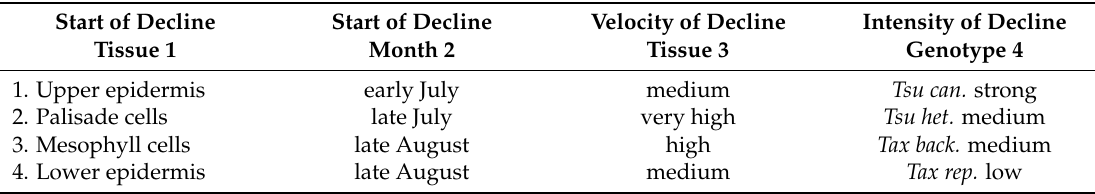
Table 2. Start and monthly sequence of the decline of the 4 needle tissues (Columns 1 and 2). Furthermore, the velocity and intensity of the decline of the four tissues and genotypes (Columns 3 and 4) are